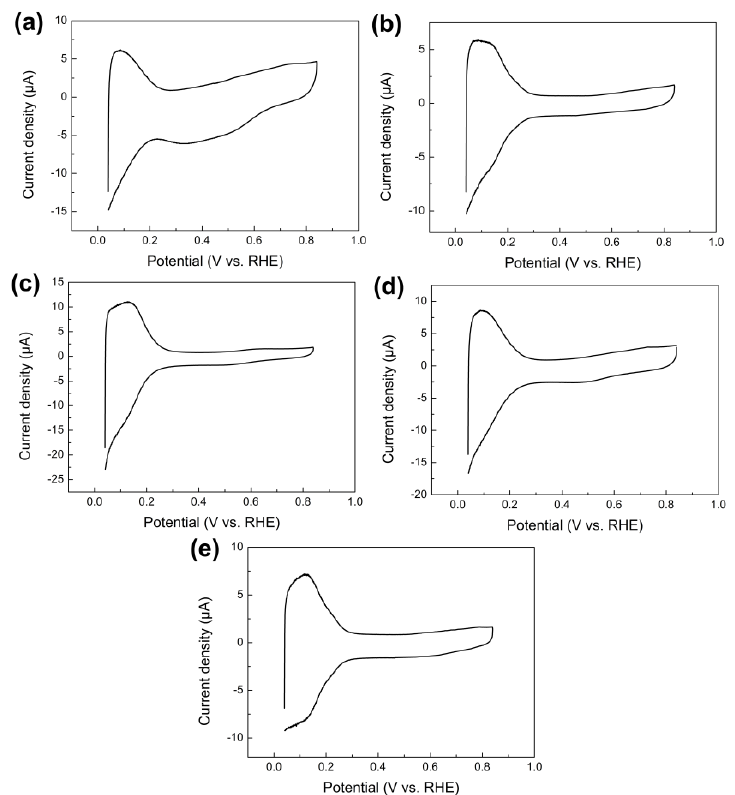
Figure 6. CVs measured on ( a ) Pt ML /Ru nanoparticles, ( b ) Pt ML /Rh nanoparticles, ( c ) Pt ML /Pd nanoparticles, ( d ) Pt ML /Ir nanoparticles, and ( e ) Pt ML /Au nanoparticles on the GCE in 0.5 M H 2 SO 4 solution, respectively.